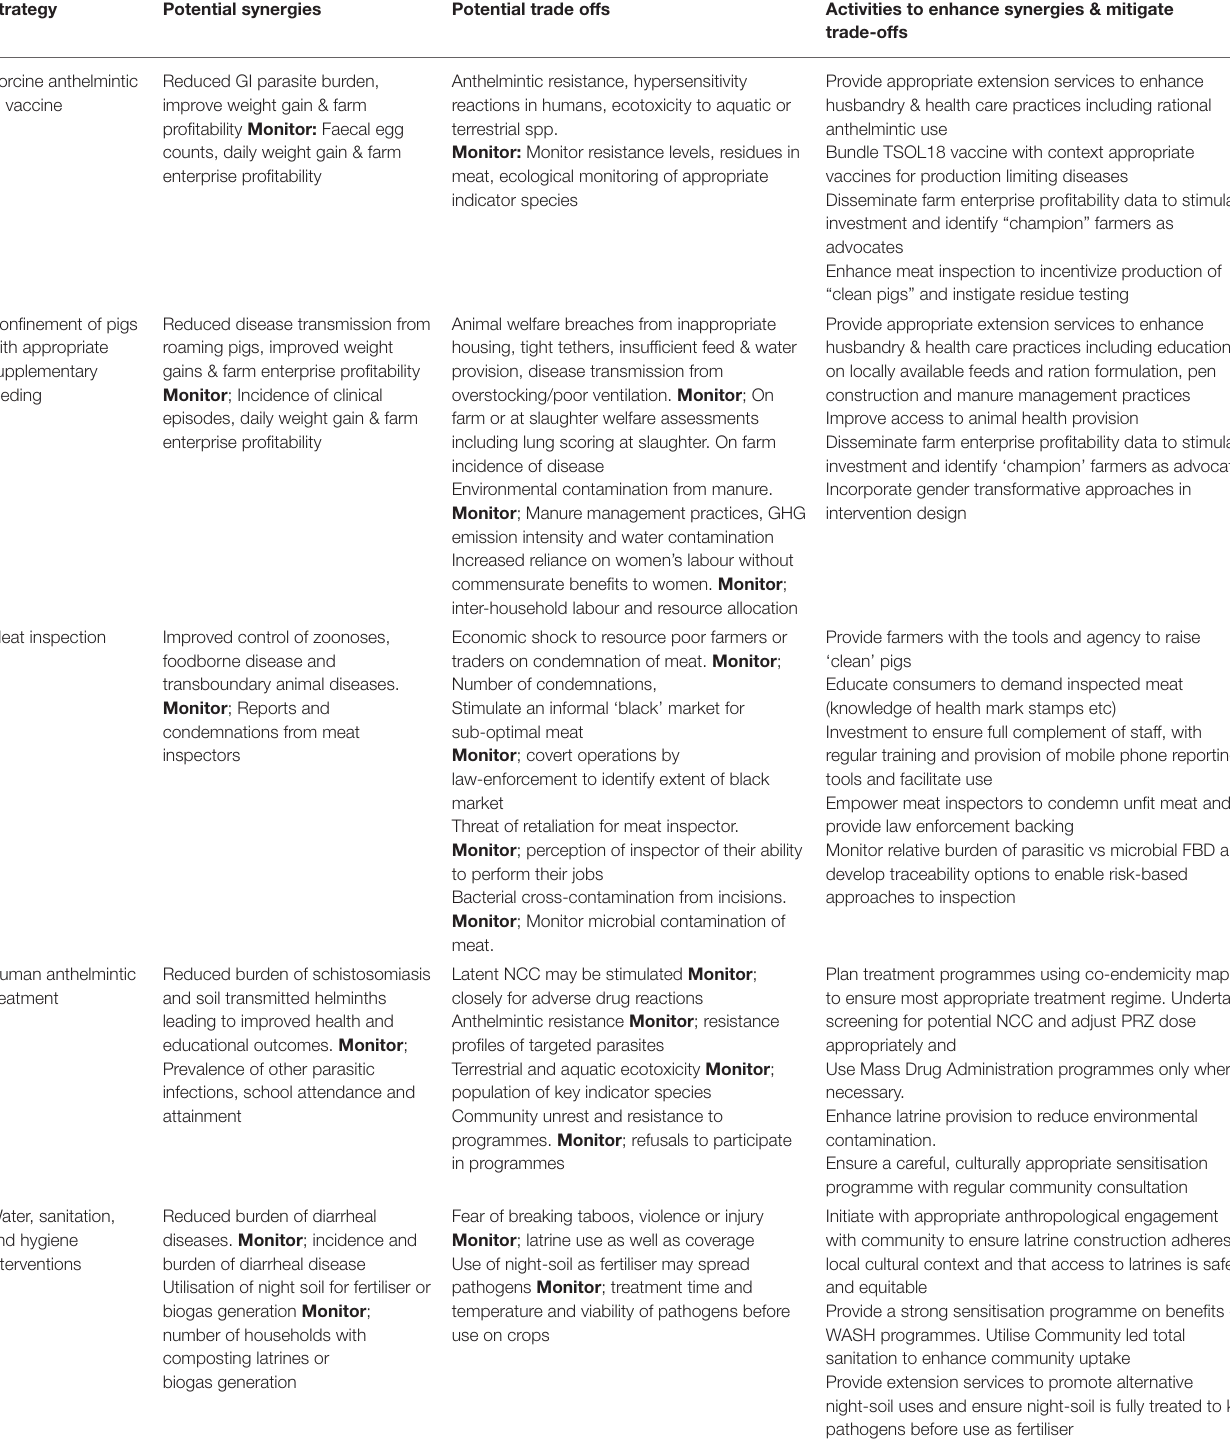
TABLE 1 | Summary of control strategies with potential synergies and trade-offs. Strategy Potential synergies